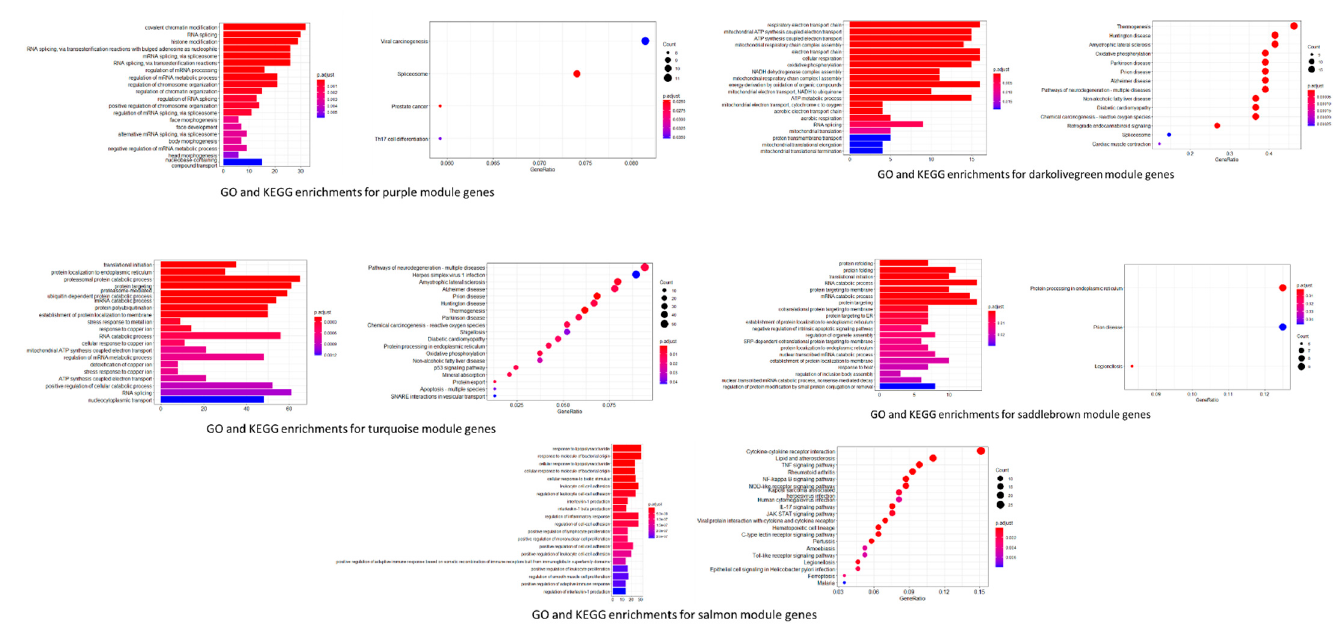
Figure 3. The GO and KEGG enrichment analysis for the genes in modules. The module genes of purple, darkolivegreen, turquoise, saddlebrown, and salmon modules were analyzed and the top 20 of the enrichment GO-term and KEGG-pathway based on the adjusted p -value were shown in the figures in the order of p -values.